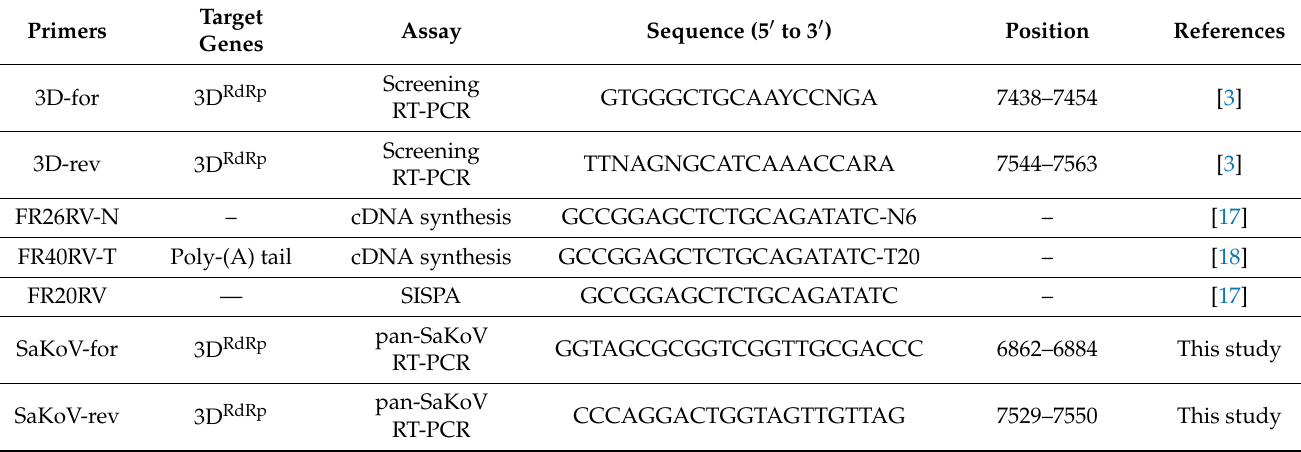
Table 1. List of primers used in this study. Nucleotide position refers to feline SaKoV-A strain FFUP1 (GenBank accession no.